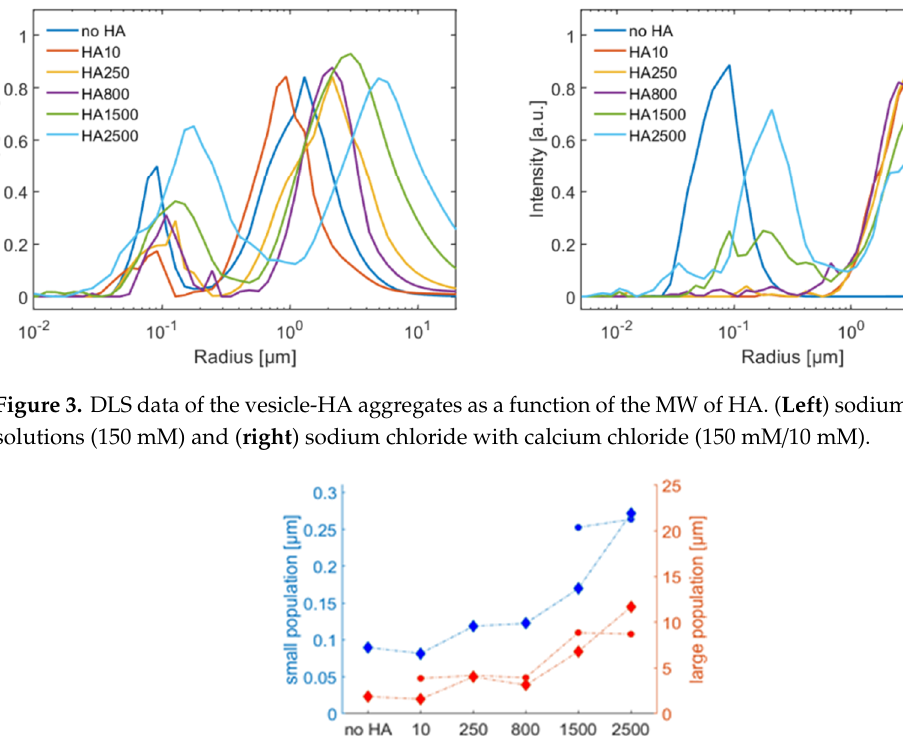
Figure 3. DLS data of the vesicle-HA aggregates as a function of the MW of HA. ( Left ) sodium chloride solutions (150 mM) and ( right ) sodium chloride with calcium chloride (150 mM/10 mM).